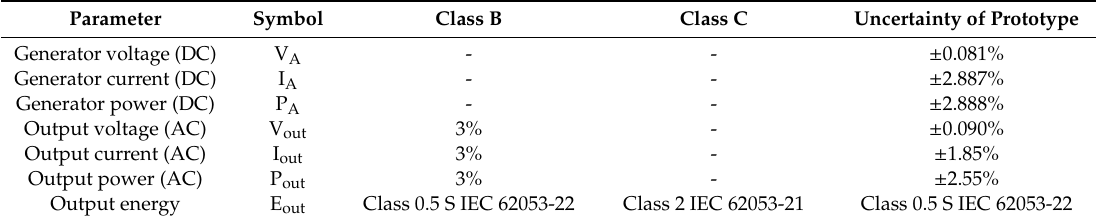
Table 4. Study of uncertainty.